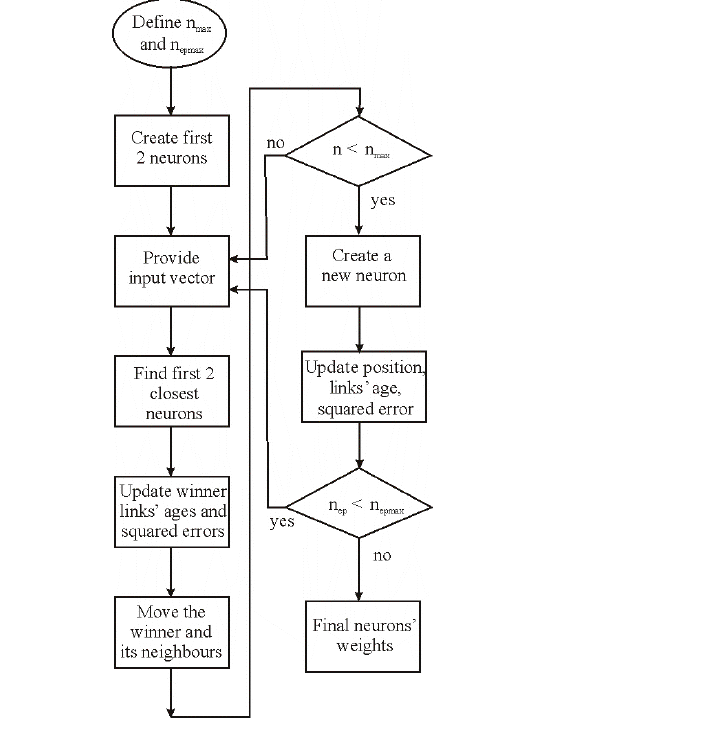
Figure 1. Flowchart describing the training algorithm of the Growing Neural Gas Artificial Neural Network.